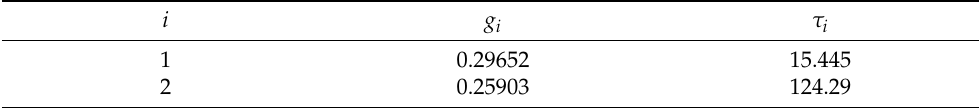
Table 3. OCA parameters of the second-order Prony